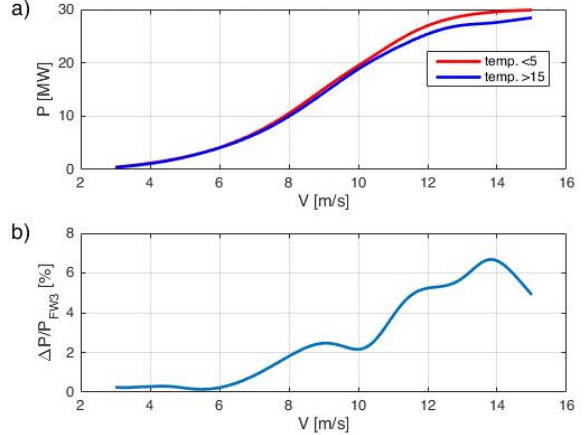
Figure 9. Wind power plant FW3: ( a ) power characteristics for T < 5 ◦ C i T > 15 ◦ C determined using neural networks, ( b ) power plant power difference for both cases as percentage of the farm’s rated output.